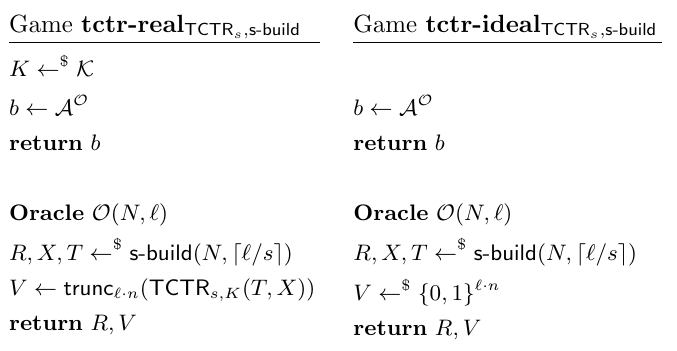
and tctr-ideal TCTR s , s-build